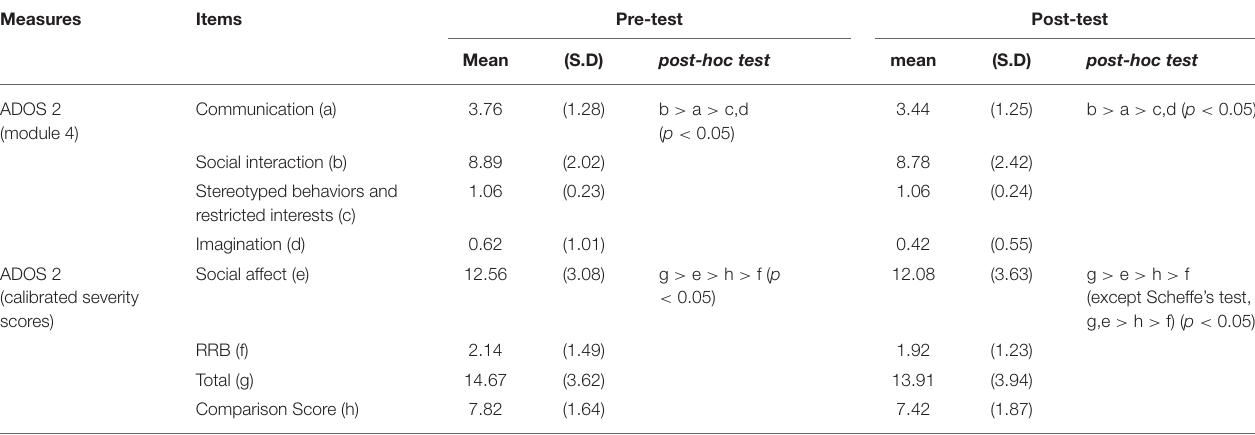
TABLE 4 | Post-hoc test with Bonferroni correction, Fisher’s LSD, Tukey’s studentized range test, Scheffe’s contrasts test in the ADOS-2 raw subtotals, and calibrated severity scores.